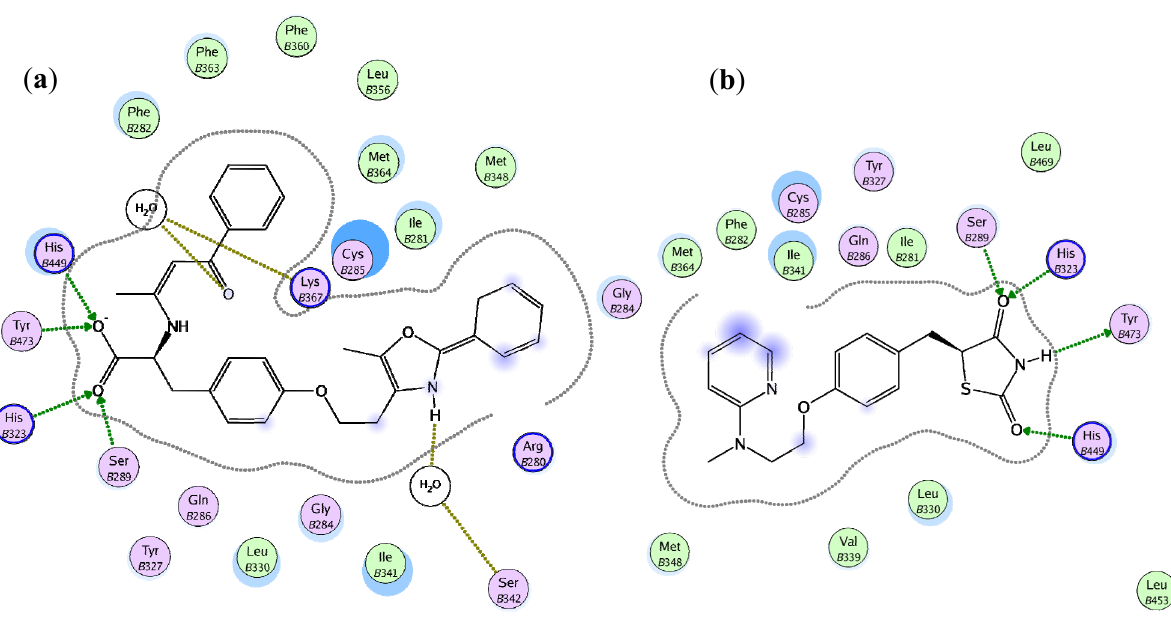
Figure 6. Ligand-interaction diagrams of ( a ) rosiglitazone and ( b ) GW409544 within the binding pocket of PPAR γ .